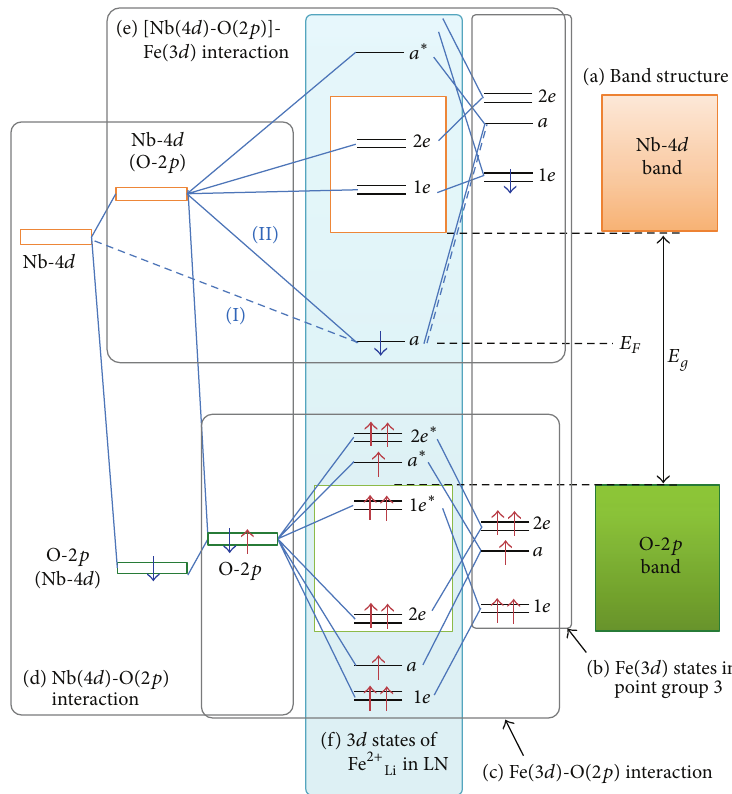
Figure 3: Proposed energy diagram resulting from the orbital interactions among Fe-3 d , Nb-4 d , and O-2 p : (a) the schematic band structure of LN and (b) the Fe-3 d states in point group 3. (c) The orbital hybridization between Fe-3 d and O-2 p yielding the defect states in the majority spin ( ↑ ) band. (d) The Nb-4 d and O-2 p interaction leading to the O(2 p )-dominant states O(2 p )[Nb(4 d )] in the VB and the Nb(4 d )- dominant states Nb(4 d )[O(2 p )] in the CB. (e) The orbital interactions between Fe- 3𝑑 𝑧 2 and the adjacent orbitals (Nb-4 d and O-2 p ) leading to the defect states in the minority spin ( ↓ ) band. (f) The energy levels with an electronic configuration of the Fe 2+ (3 d 6 )-related defect states: 1 e 2 𝑎 1 2 e 2 1𝑒 ∗2 𝑎 ∗1 2𝑒 ∗2 in the ↑ band and 𝑎 1 1 e 0 2 e 0 𝑎 ∗0 1𝑒 ∗0 2𝑒 ∗0 in the ↓